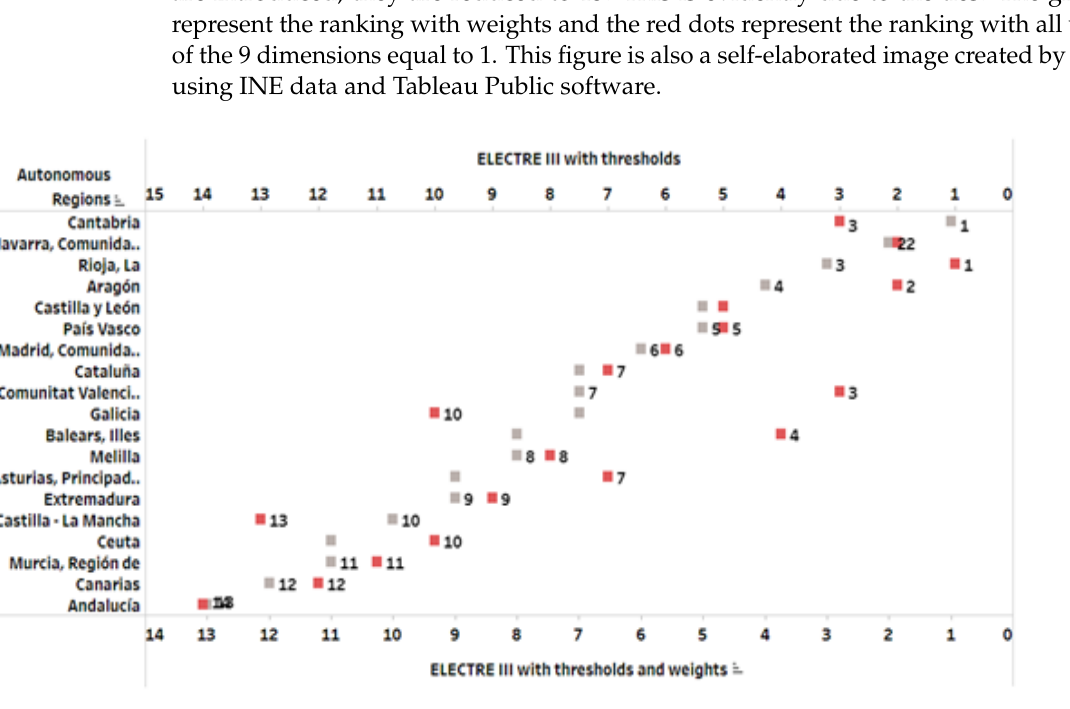
Figure 9. Our ranking generated by ELECTRE III two-stage approach with thresholds on the indicators of the dimensions with and without weights.